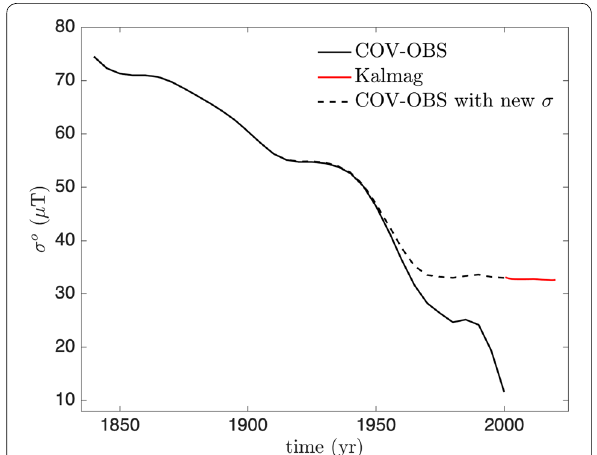
Fig. 2 RMS uncertainty σ o , evaluated at the core surface, of COV-OBS.x1 and Kalmag truncated to spherical harmonic degree ℓ = 14 . Also shown are the COV-OBS.x1 uncertainties when corrected with lower bounds determined by Kalmag